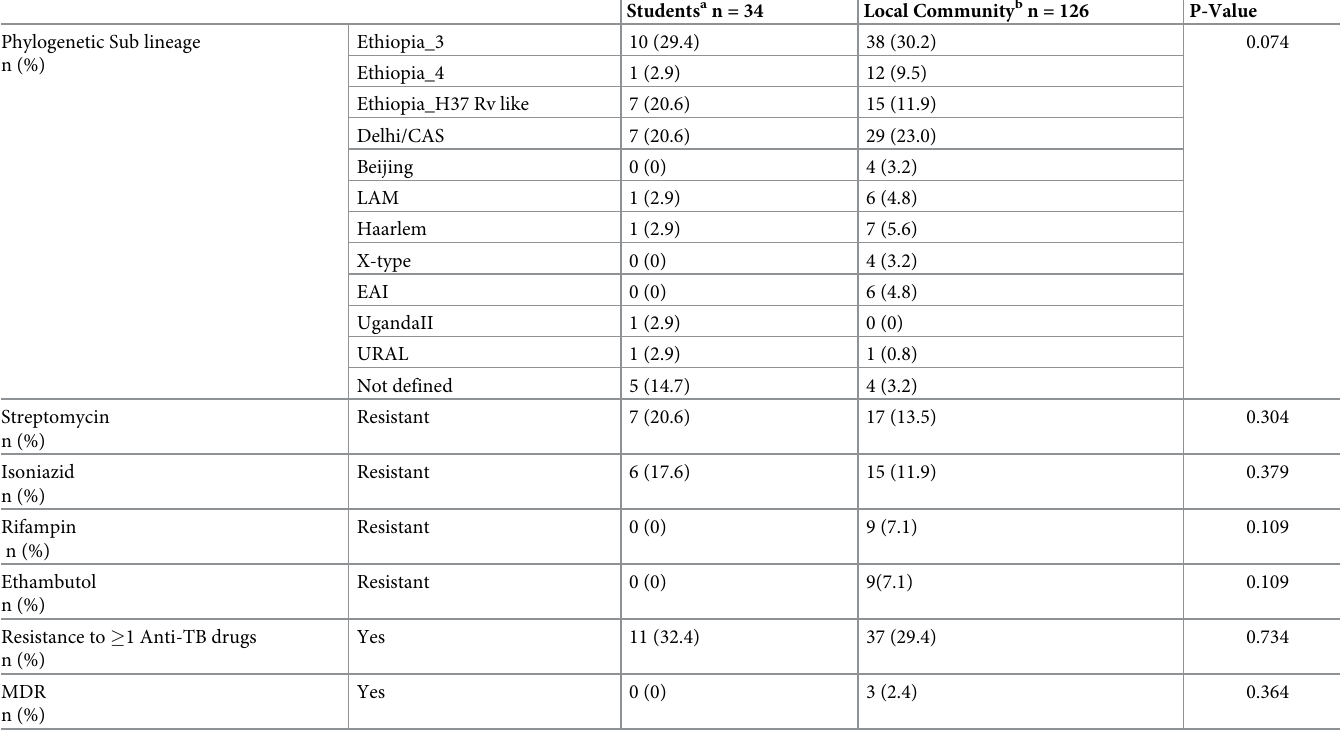
Table 2. Phylogenetic sub-lineages and drug susceptibility patterns of Mycobacterium tuberculosis isolates from university students and members of the surround- ing community diagnosed with pulmonary tuberculosis in Eastern Ethiopia.